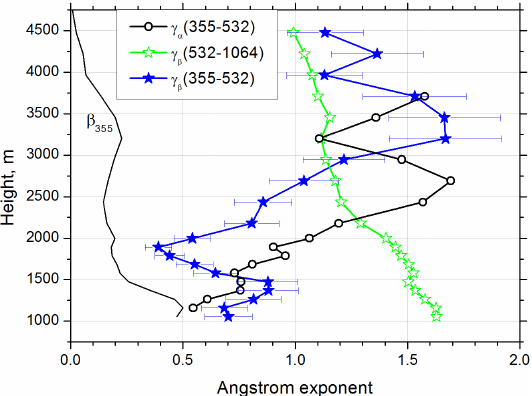
Figure 21. Vertical profiles of the backscatter Ångström exponents γ β (355–532) and γ β (532–1064) together with γ α (355–532) mea- sured on 27–28 August during 23:20–01:20UTC. Solid lines show profile of backscattering coefficients at 355nm without scale.